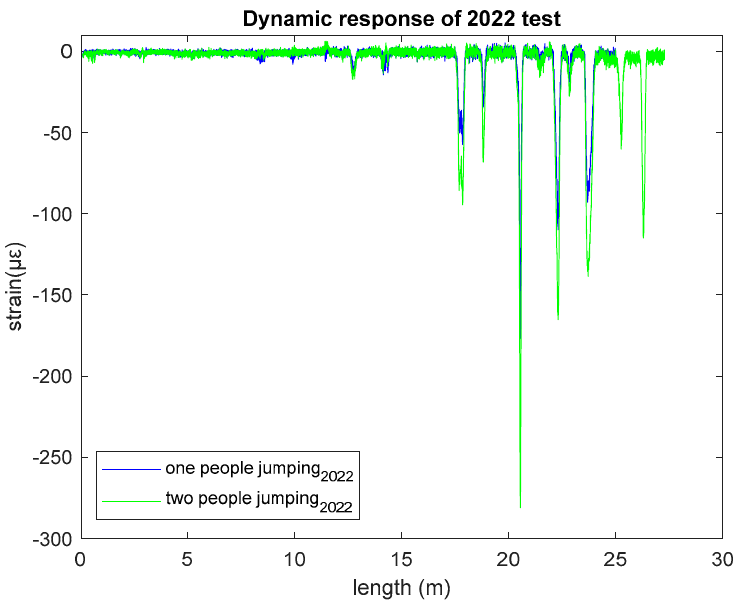
Figure 6. Dynamic response of 2022 test.